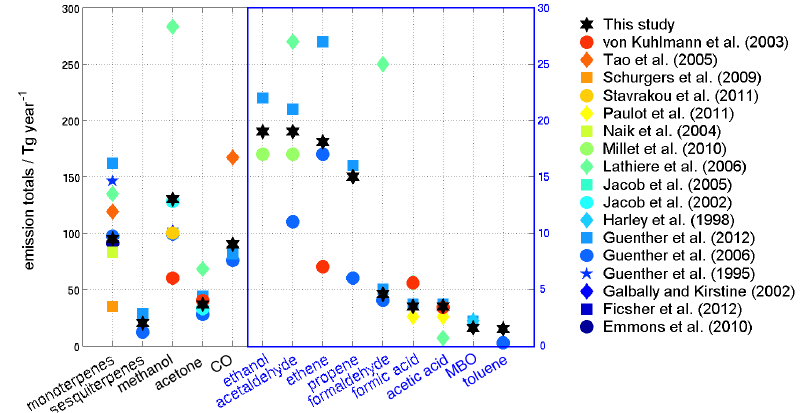
Figure 14. Comparison of MEGAN–MACC global emission totals (Tgyr − 1 ) of species other than isoprene with emission estimates of previous studies (list of coloured symbols on the right). Note the two vertical axes in black and blue with different scales.